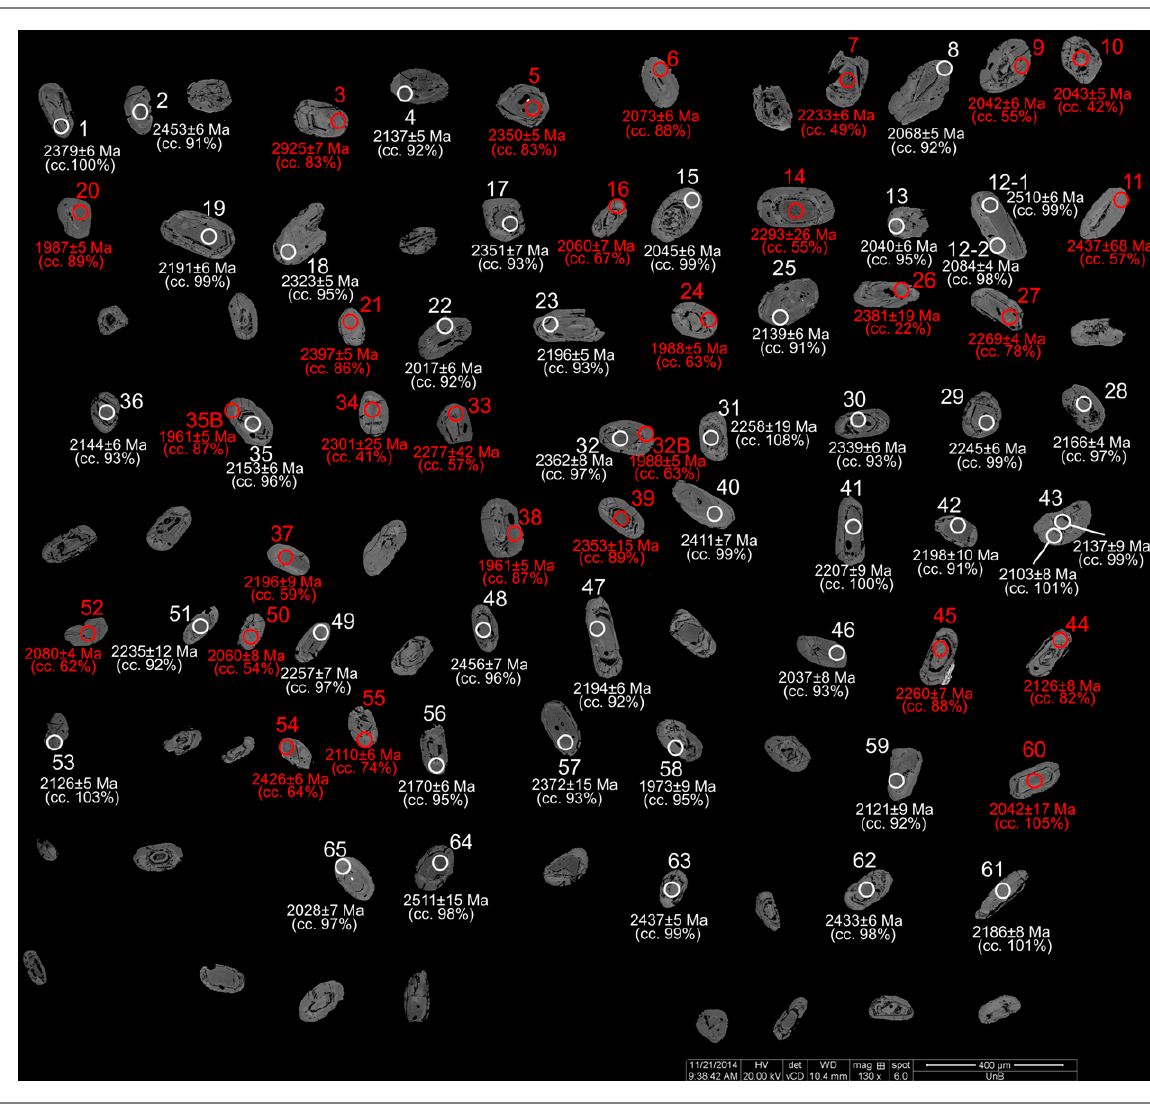
FIGURE 4 – Backscattered electrons images of detrital zircons grains with location of the spots of LA-ICPMS U-Pb dating and related 207 Pb/ 206 Pb